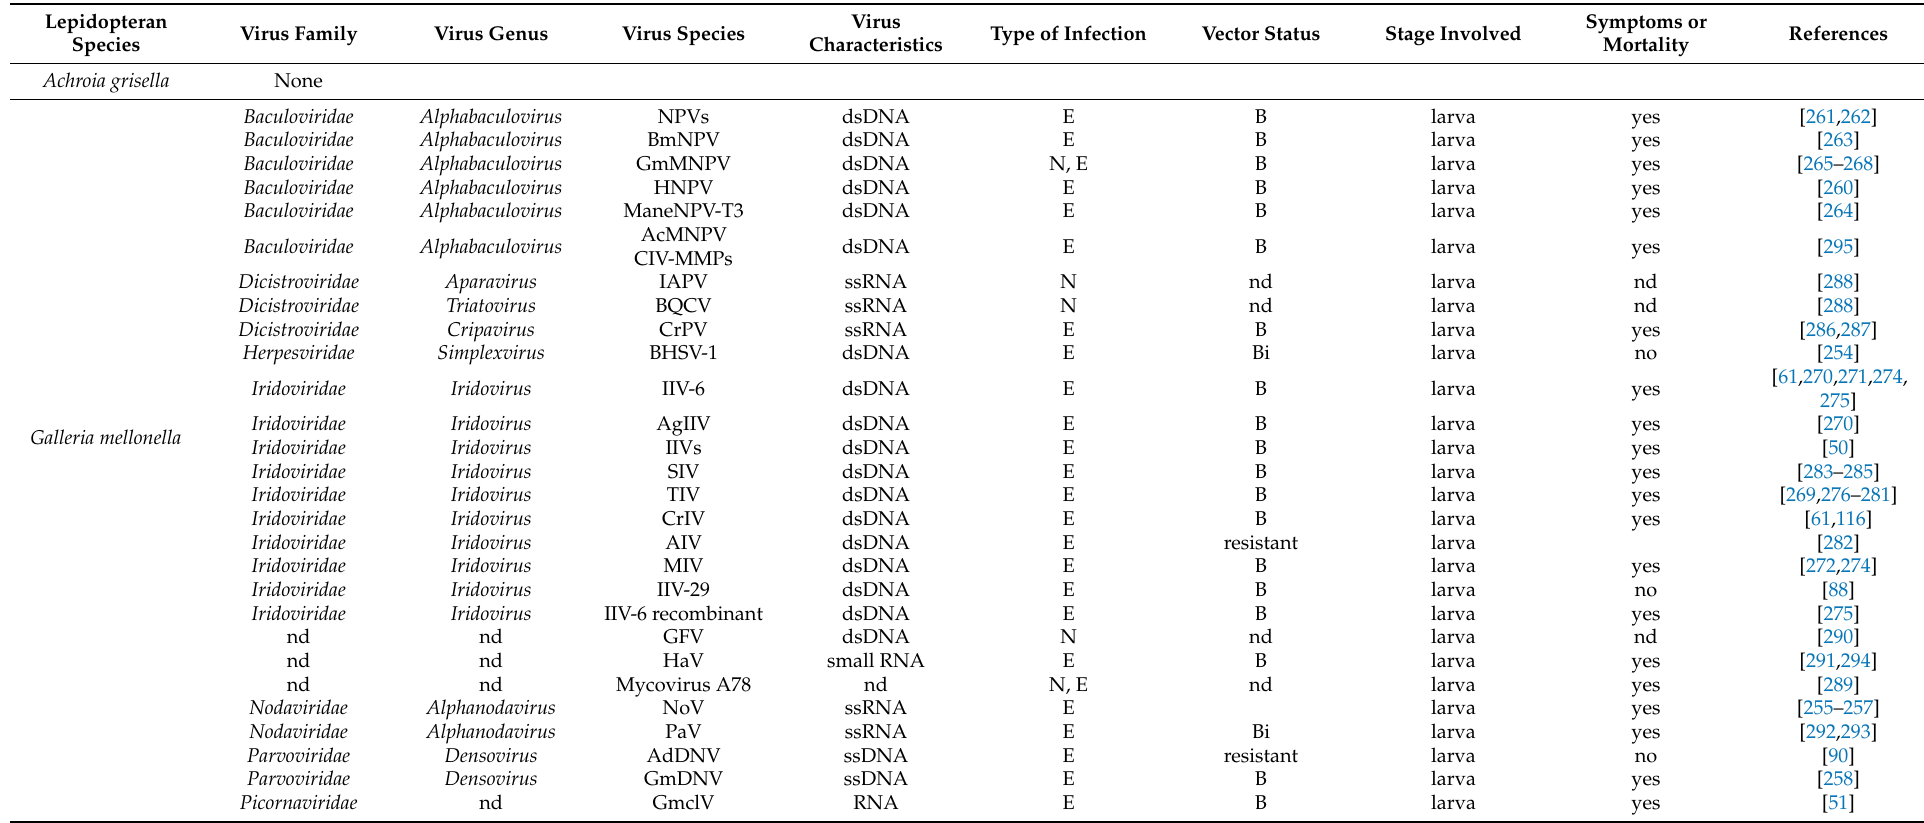
Table 5. Viruses detected in lepidopteran edible